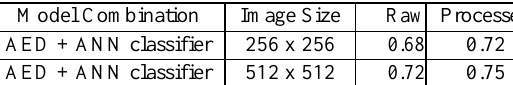
Figure 18. Accuracies of training ANNs on AutoEncoder Encodings